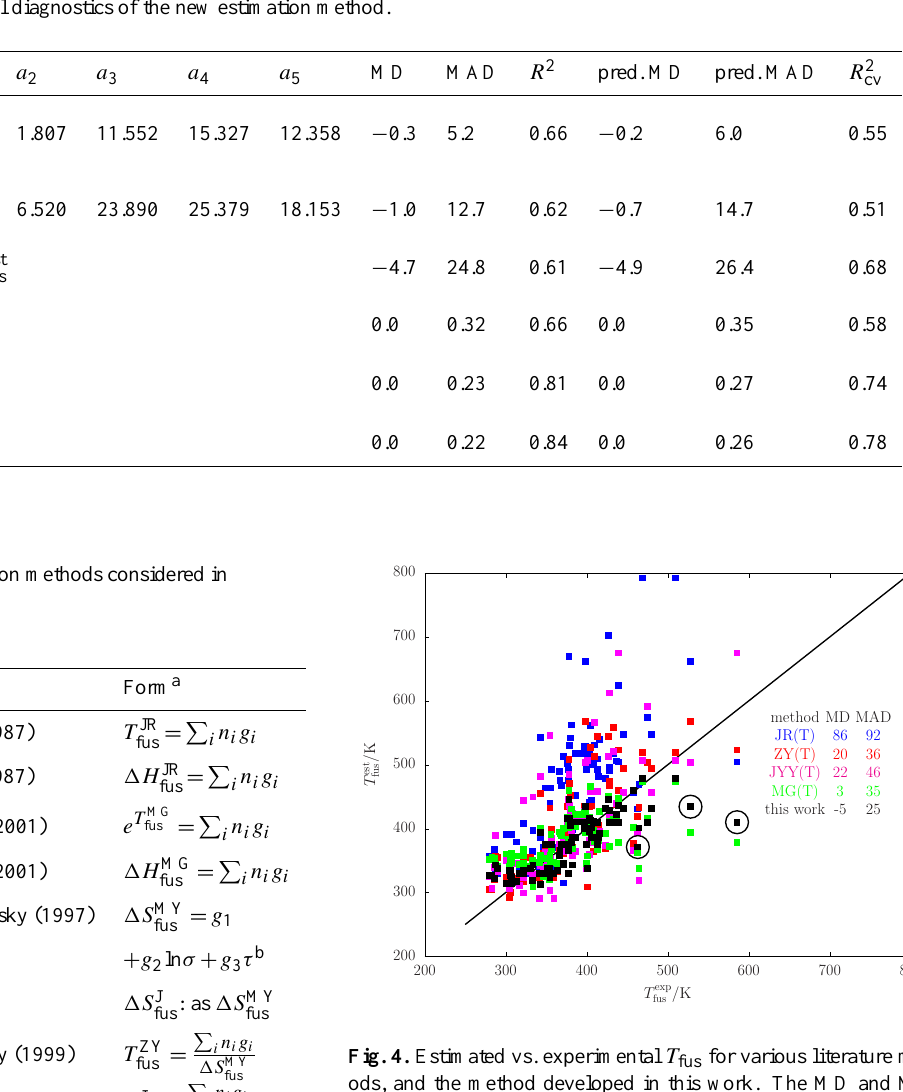
Table 1. Parameters and statistical diagnostics of the new estimation method.